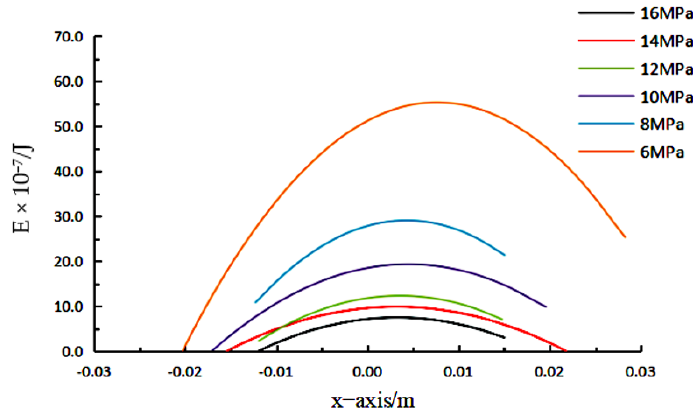
Figure 24. Directional kinetic energy E distribution fitting curve.